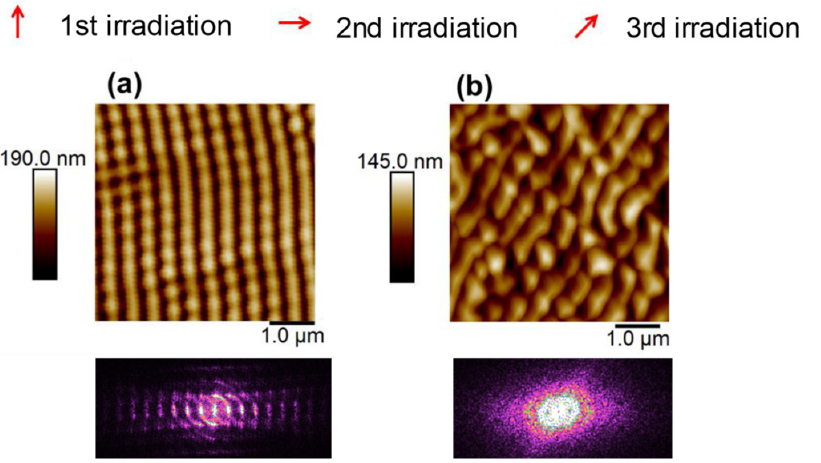
Figure 4. AFM images of combined LIPSS formed by sequential irradiation in P3HT at λ = 532 nm by varying the polarization vector of the laser: ( a ) 3600 + 100 + 100 pulses; ( b ) 3600 + 1800 + 1800 pulses. Next to each AFM figure, its corresponding FFT is shown.